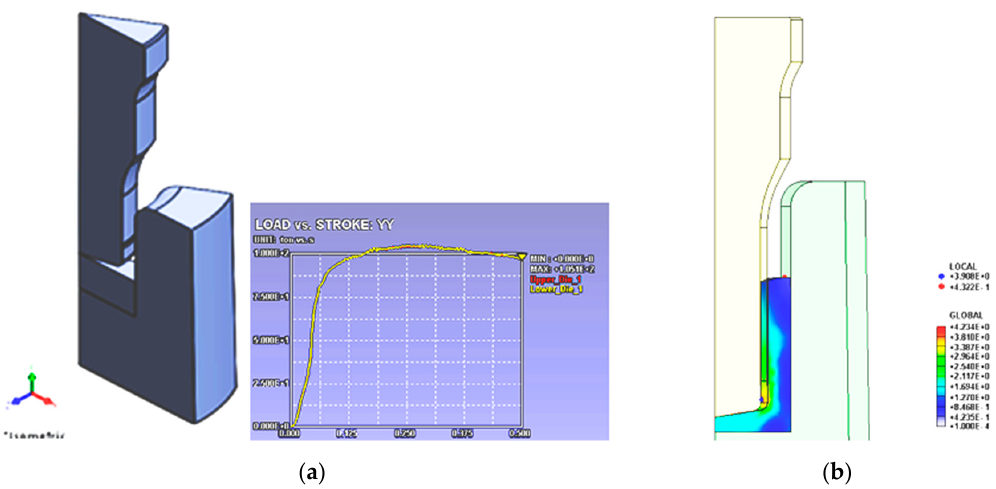
Figure 2. ( a ) 3D model assembly of punch, billet, and die; ( b ) finite element (FE) simulation results with load versus stroke graph.